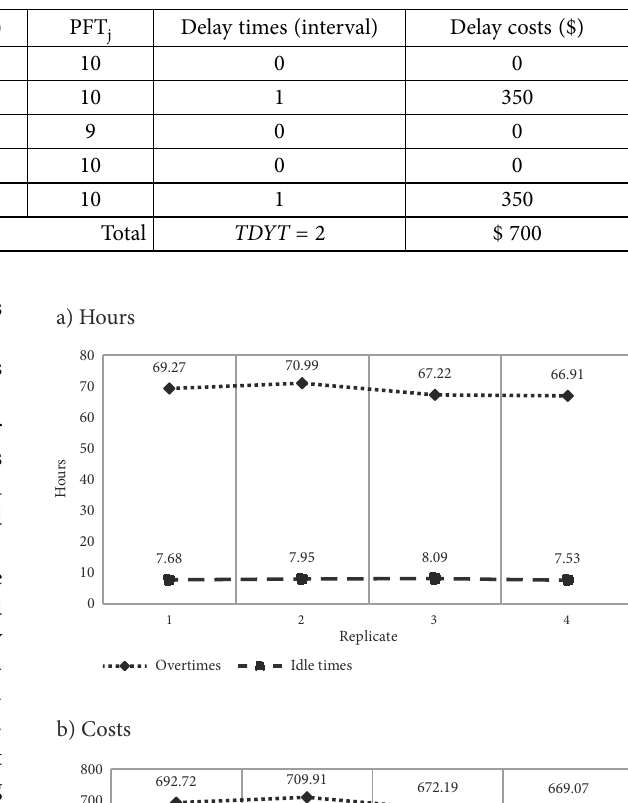
Table 14. The estimated project delay costs